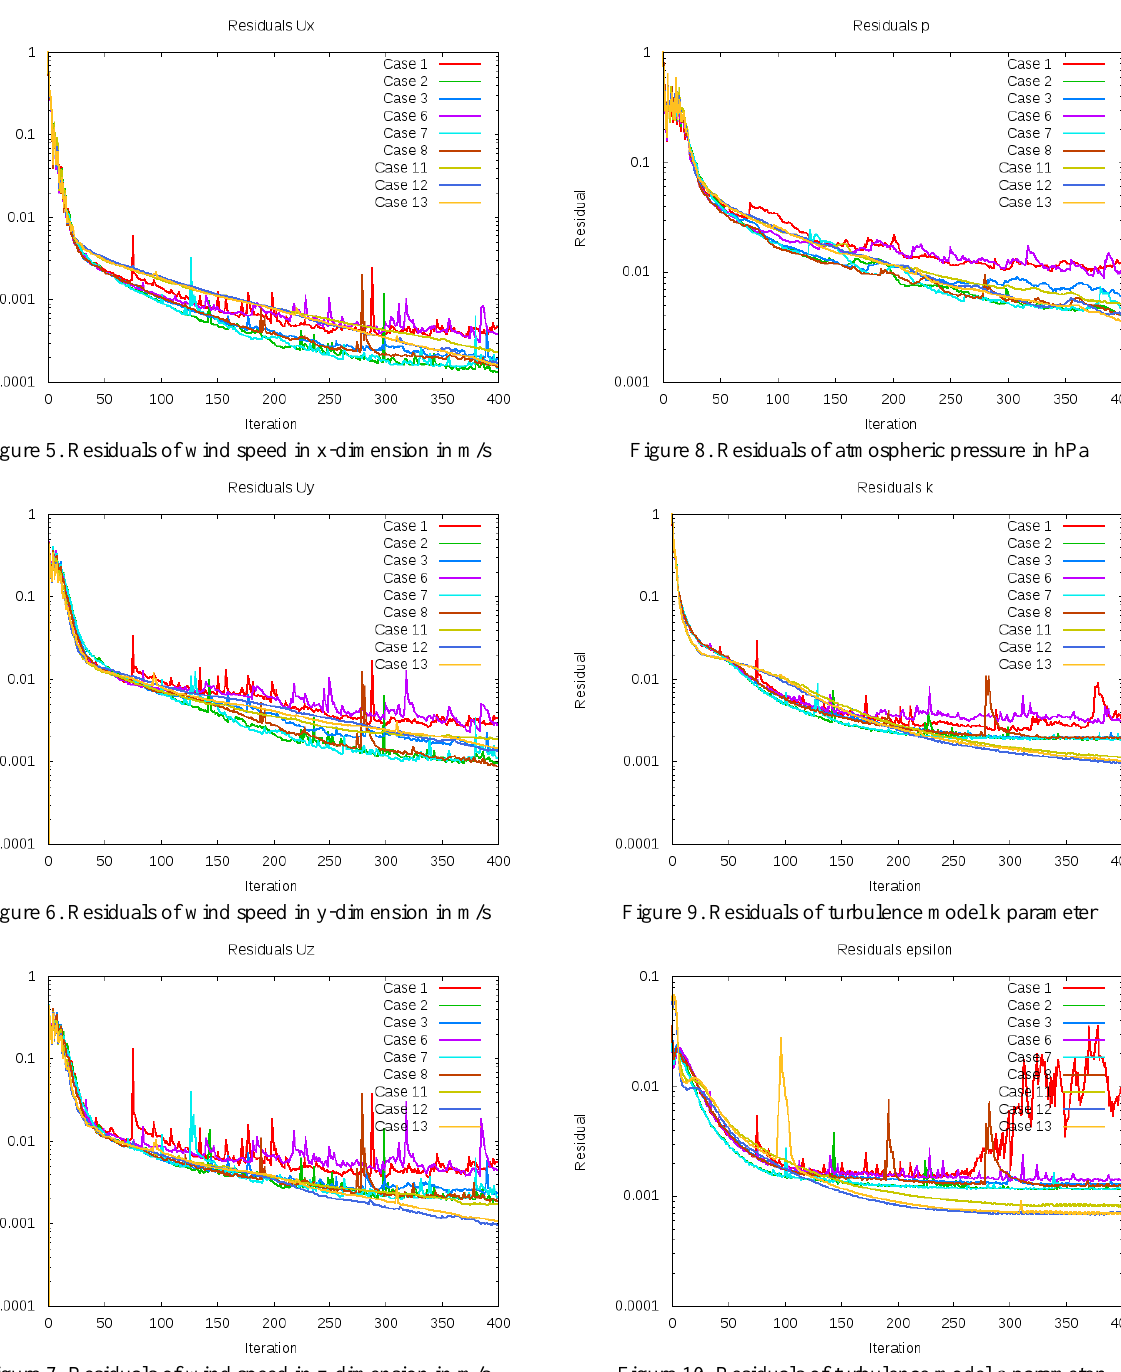
Figure 7. Residuals of wind speed in z-dimension in m/s